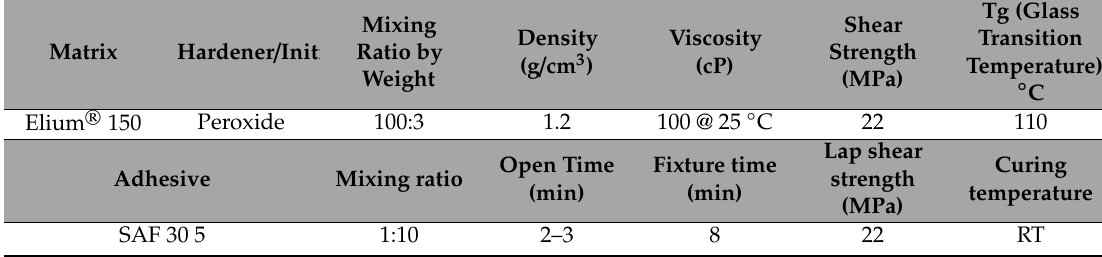
Table 1. Mechanical, curing, and bonding characteristics of the resin and adhesives used in the current project. InitiatorMixing Matrix Hardener / Ratio by Weight